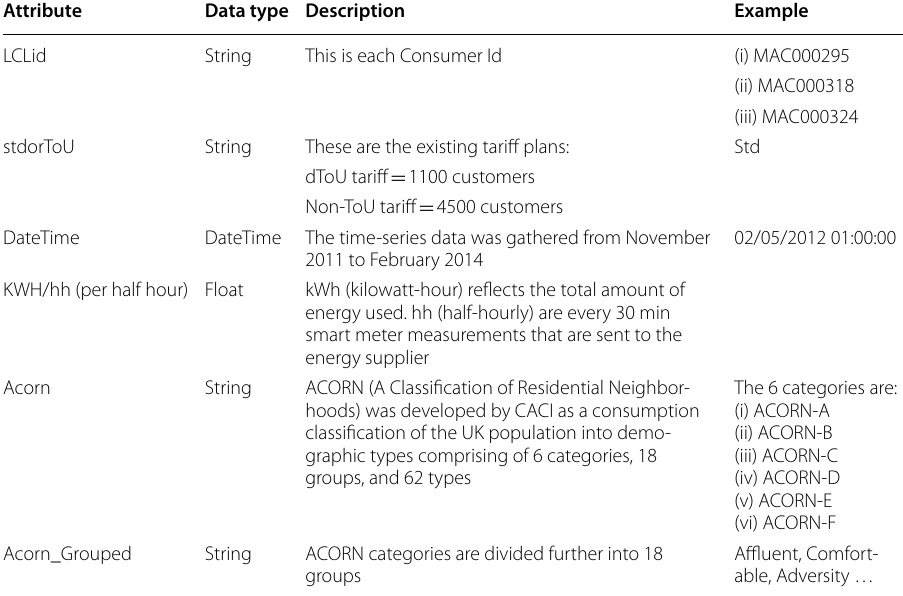
Table 1 Description of